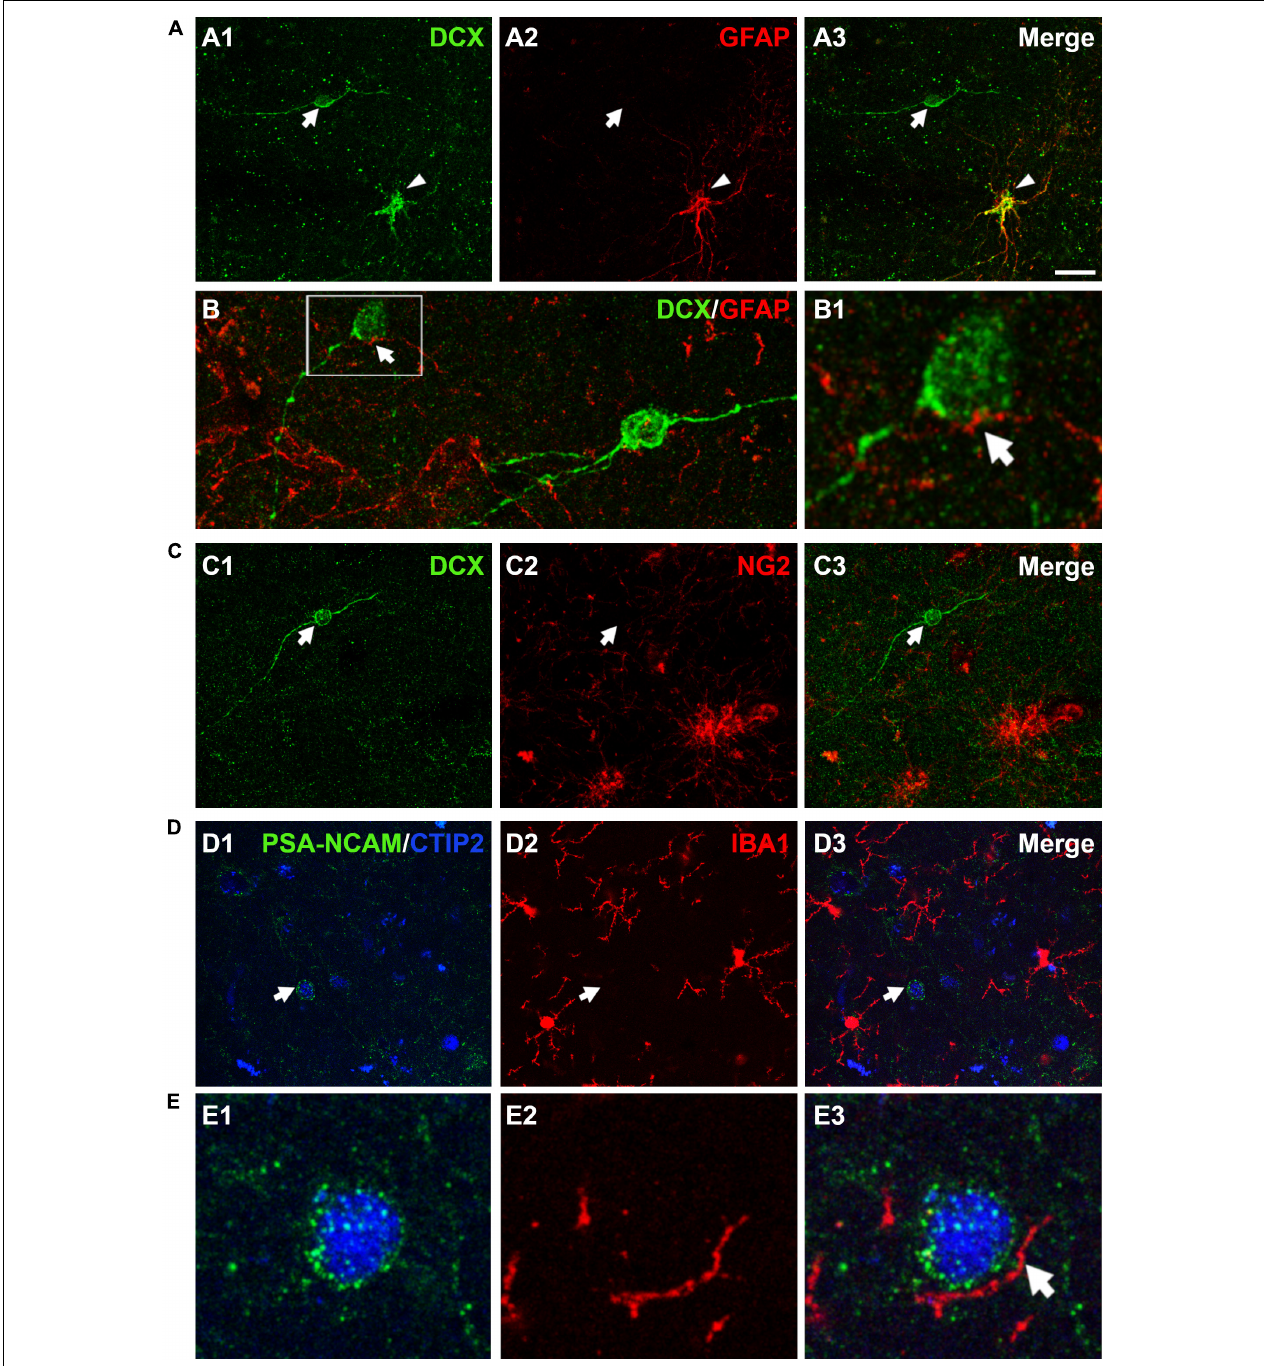
FIGURE 5 | Expression of glial cell markers in the immature neurons of the human cerebral cortex layer II. (A) Double DCX (green) and GFAP (red) immunohistochemistry. Arrow points to a type II DCX immunopositive cell devoid of GFAP expression. Arrowhead indicates a DCX/GFAP double labeled cell. (B) Confocal reconstruction of a type II DCX immunoreactive cell (green) contacted by different astroglial processes (red). (B1) Depicts a higher magnification view of the squared area in (B) , in which the arrow indicates a GFAP immunopositive process closely apposed to the DCX + soma. (C) DCX immunopositive type II cell (green, arrow) devoid of NG2 expression (red, arrow). Note the presence of 2 NG2 immunoreactive cells lacking DCX expression in the lower portion of the figure. (D) No co-localization was observed between a PSA-NCAM + /CTIP-2 + double labeled neuron (arrow) and IBA1 immunopositive cells (red). The transcription factor CTIP2 was used to confirm the excitatory phenotype of PSA-NCAM immunoreactive neurons in layer II. (E) High magnification view showing an IBA1 + process (arrow) closely apposed to the soma of a PSA-NCAM expressing cell. All images are 2D projections of 15 confocal stacks (1 µ m apart). Scale bar: 30 µ m for (A,C,D) ; 10 µ m for (B) ; 5 µ m for (B1) and 6 µ m for (E) . All confocal images in this figure were from neurosurgical